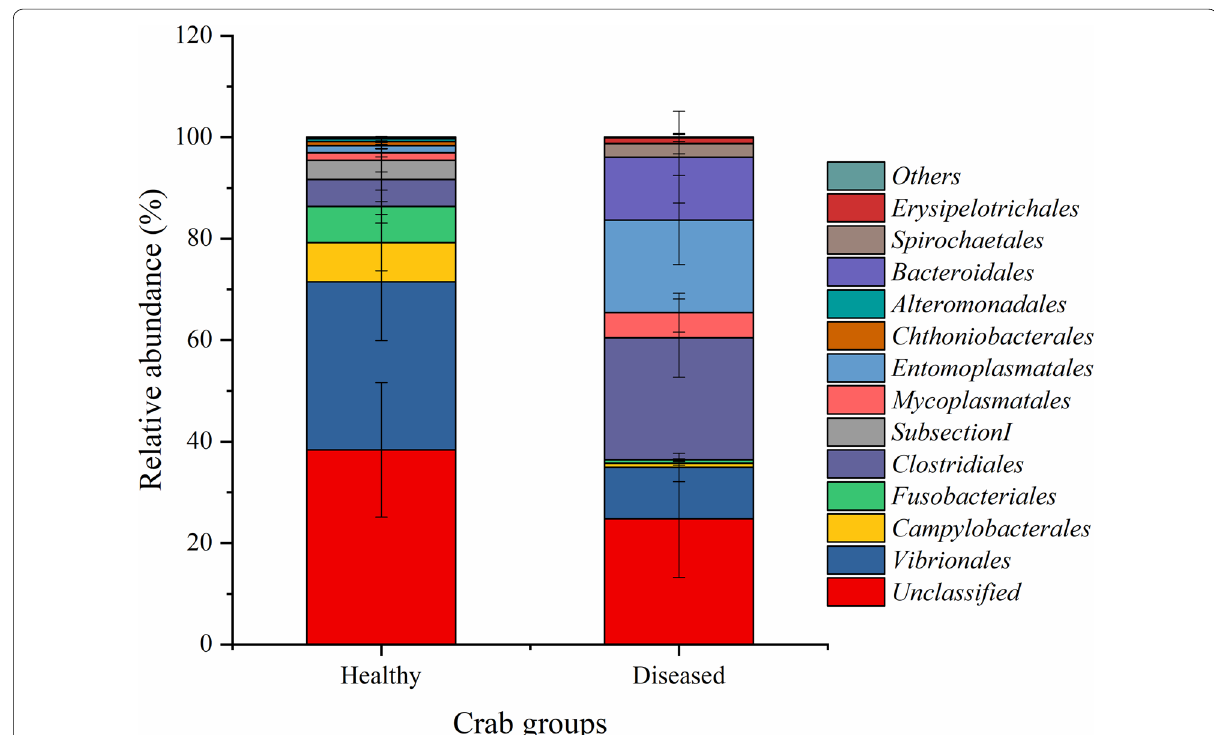
Fig. 2 Microbial community composition of the top 10 most abundant orders averaged over each crab group. Values show means and 1 standard error of mean (mean SEM, n 5) ± =